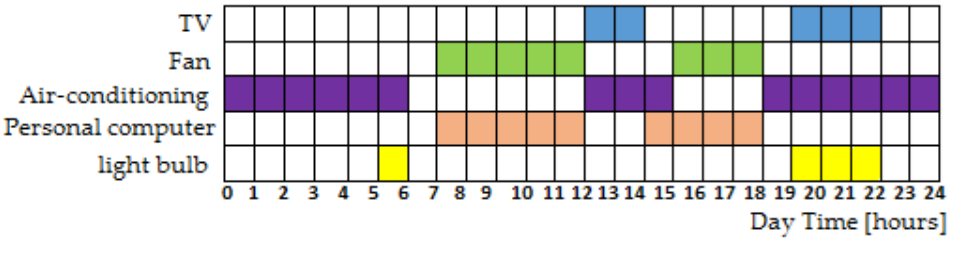
Figure 6. Use profile per